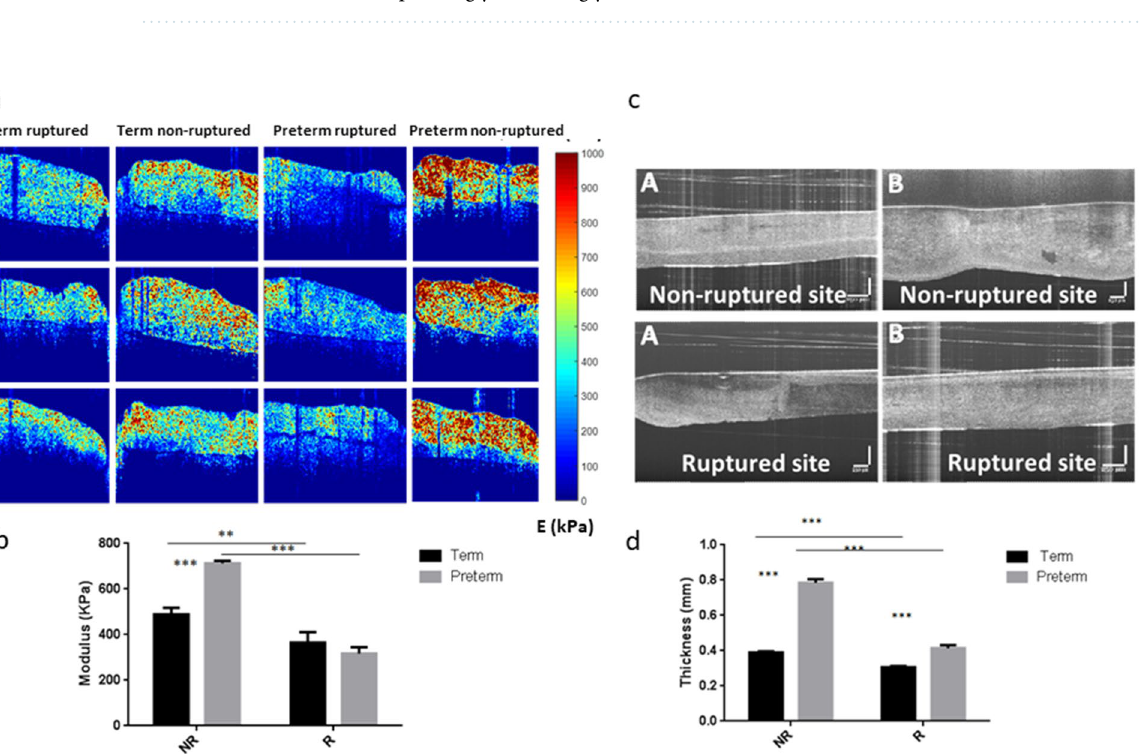
Table 1. The mechanical properties and key ECM molecules at ruptured and non-ruptured site of term and preterm membranes. The difference ratios are calculated relative to rupture site values. A amnion, C chorion, CA chorioamnion, sGAG sulphated glycosaminoglycans.